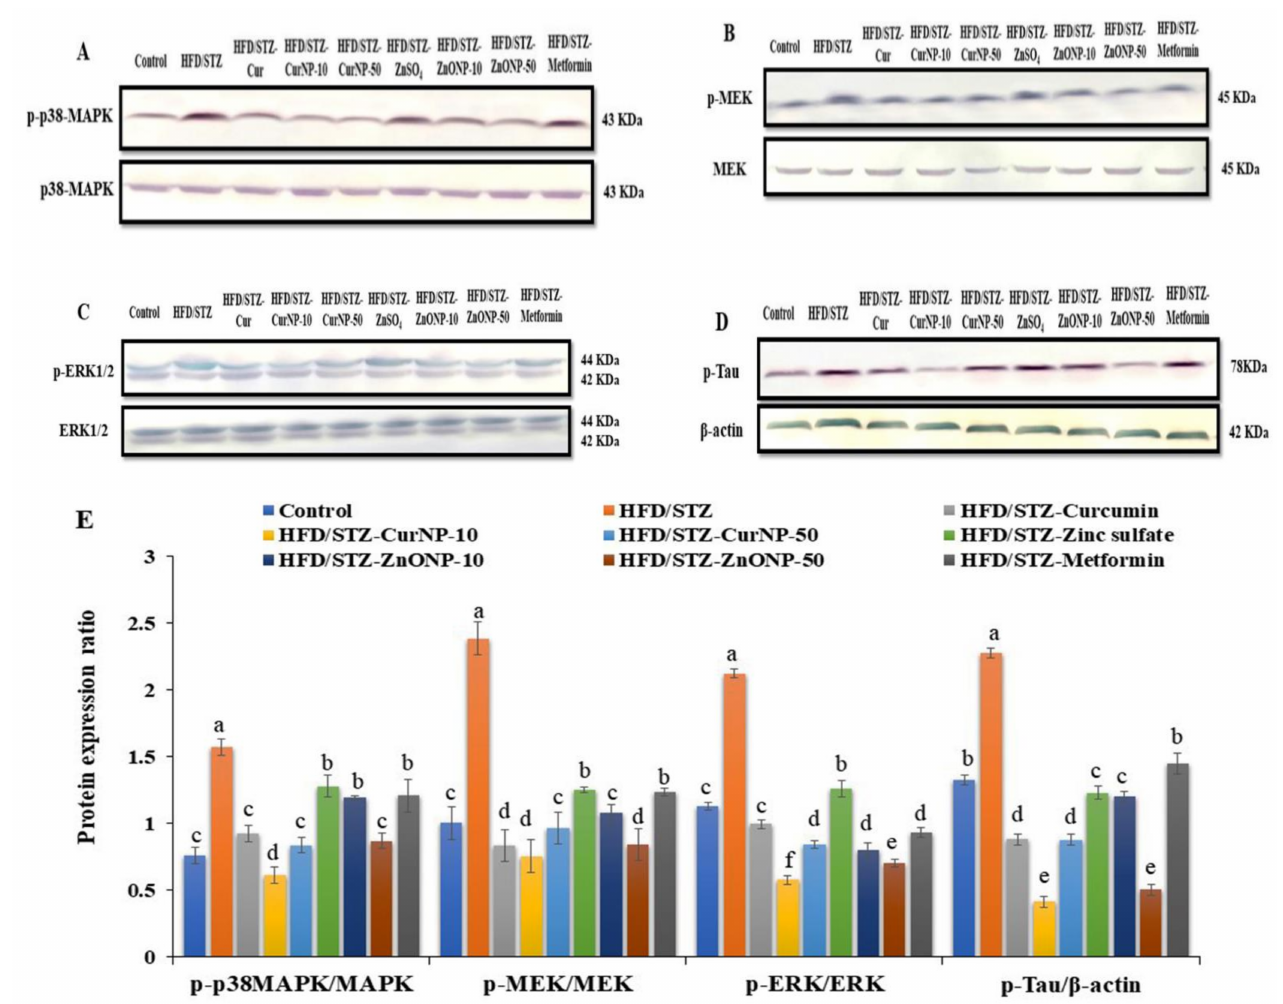
Figure 5. Protein expression ratio profile. ( A ) p-p38MAPK/p38MAPK, ( B ) p-ERK/ERK, ( C ) p-MEK/MEK, ( D ) p-Tau/ β - actin in the hippocampus of rats. ( E ) Quantitative analysis of p-p38MAPK/p38MAPK, p-ERK/ERK, p-MEK/MEK, and p-Tau/ β -actin in the hippocampus of rats. Data are expressed as mean ± SEM ( n = 3); means for the same parameter with different letters (a–f) in each bar are significantly different ( p < 0.01), the largest data value takes the letter (a) and the smallest data value takes the letter